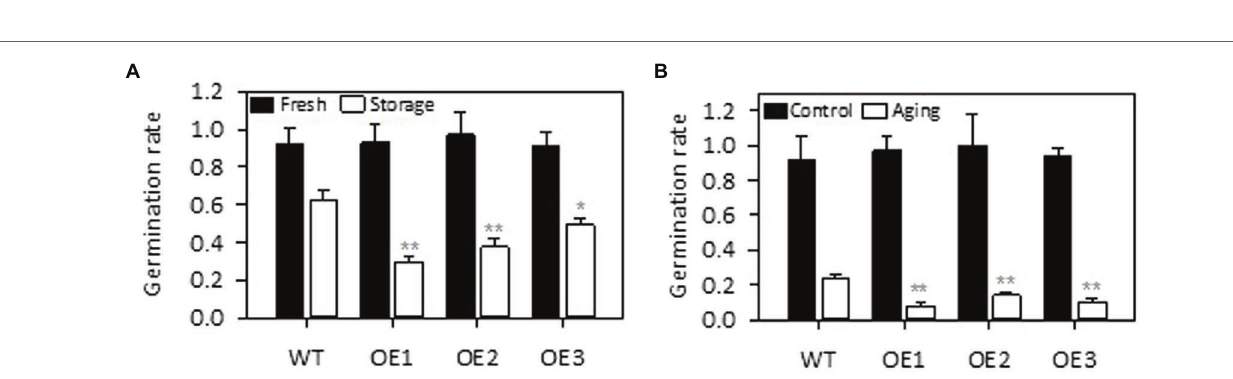
FIGURE 7 | Overexpression of AtPLD ε decreased seed viability under high humidity storage and artificial aging. The fresh harvested seeds, seeds stored under low temperature (4 ° C) and high humidity conditions for 12 months (A) , and seeds stored under high temperature (45 ° C) and high humidity conditions for 5 days (B) were used for germination rate test ( n = 4 sets of 25 seeds). The values are means ± SD. *Denotes statistical significance at p < 0.05 and **denotes statistical significance at p < 0.001 compared with WT as determined by one-way ANOVA (Duncan’s multiple range